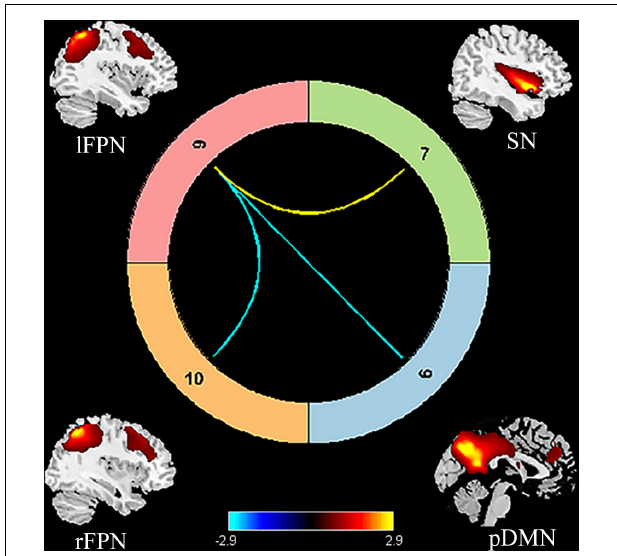
FIGURE 3 | Significant internetwork FC differences between patients with PSA and HCs. The yellow line represents significantly increased internetwork FC, and the blue lines denote significantly decreased internetwork FC in patients with PSA when compared to HCs. FC, functional connectivity; PSA, post-stroke aphasia; HCs, healthy controls; pDMN, posterior default mode network; SN, salience network; lFPN, left frontoparietal network; rFPN, right frontoparietal network.